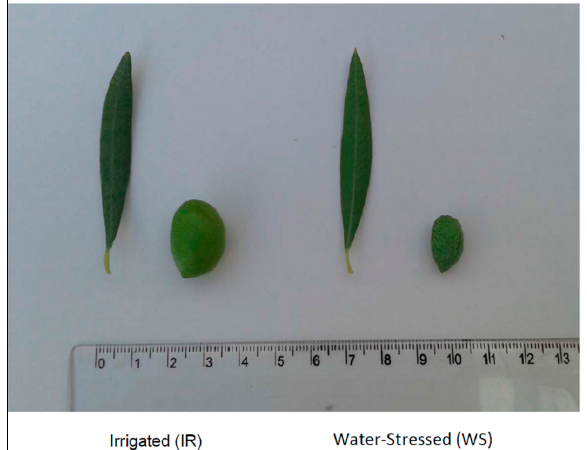
Figure 2. Aspects of fruits and leaves of the irrigated (IR) or water-stressed (WS) olive trees used in this study.